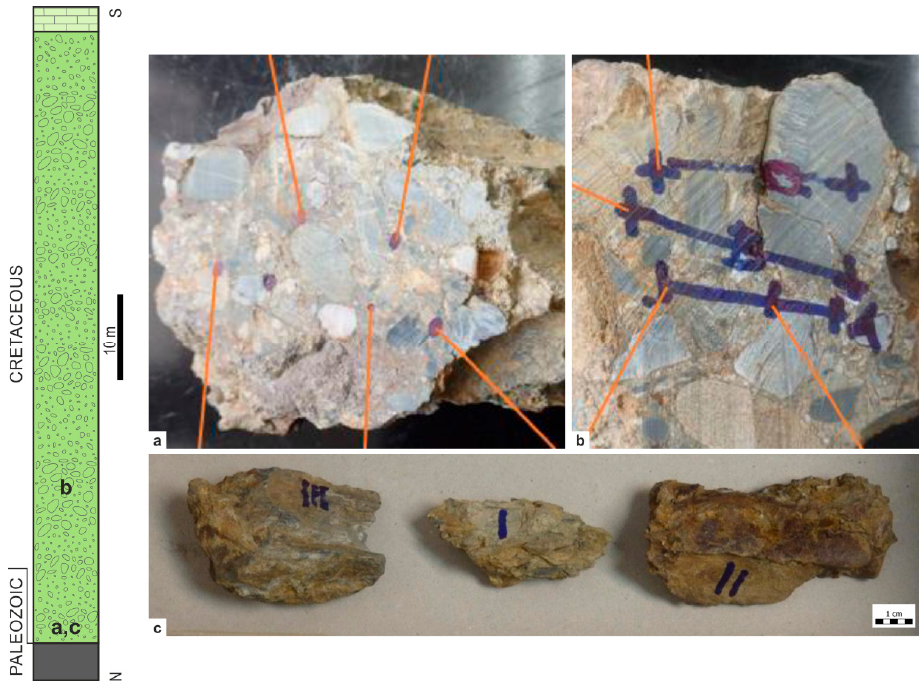
Figure 9. Samples taken for permeability ( a , b ) and porosity ( c ) analyses, at Statistic Points 1 ( c ) and 2 ( b , c ). Measuring positions within the matrix marked by numbers on photos. Position of sampling points in the matrix marked on a schematic column.